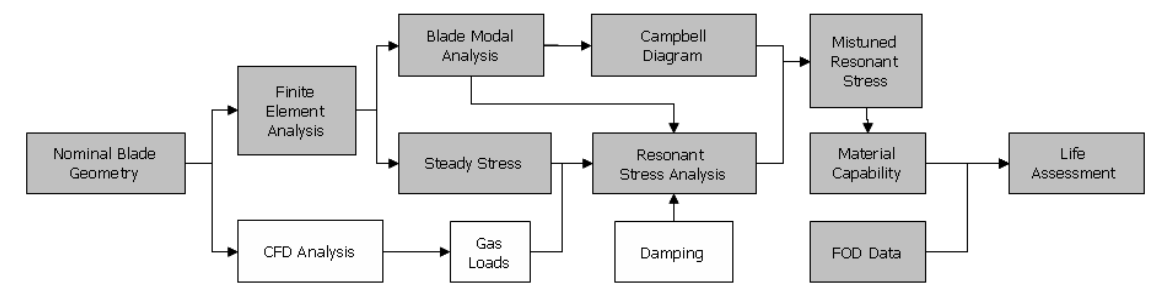
Fig. 1. Probabilistic HCF design